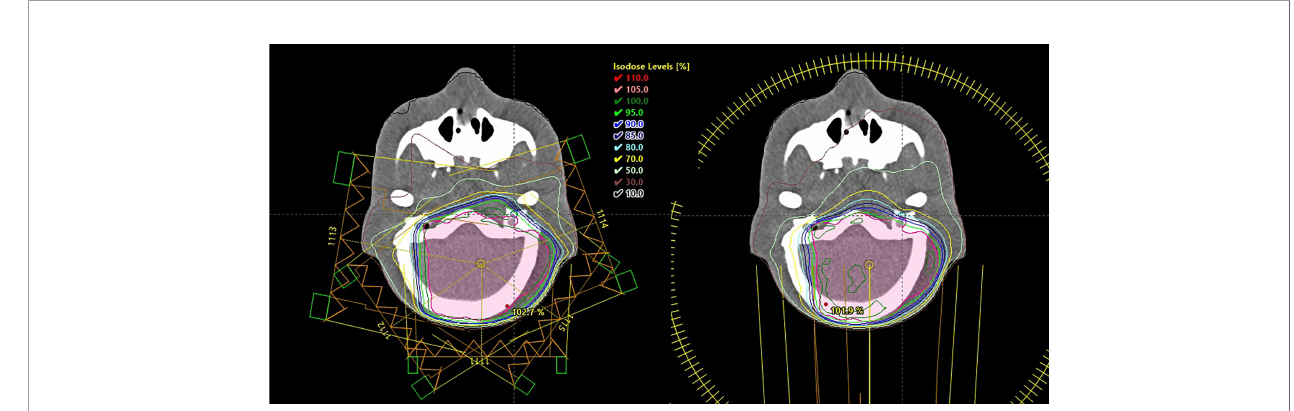
FIGURE 1 | Intensity-modulated radiotherapy (left) and volumetric modulated arc therapy (right) plans showing the isodose lines in the treated volume as computed by the treatment planning system